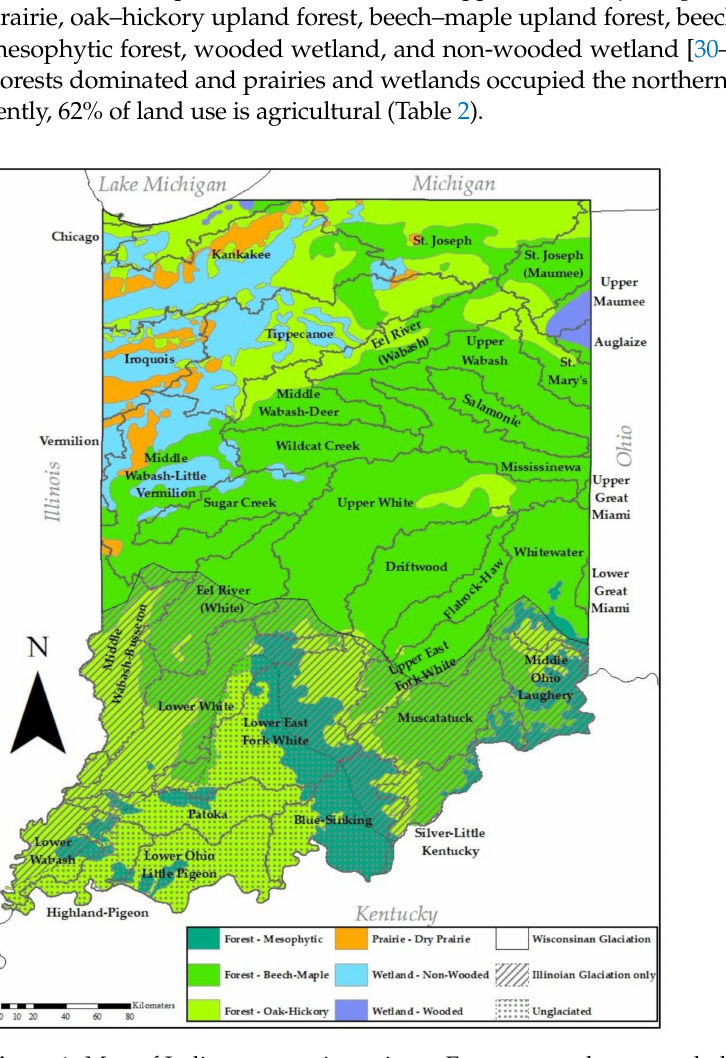
Figure 1. Map of Indiana vegetation prior to European settlement and glaciation. Adapted from Lindsey et al.